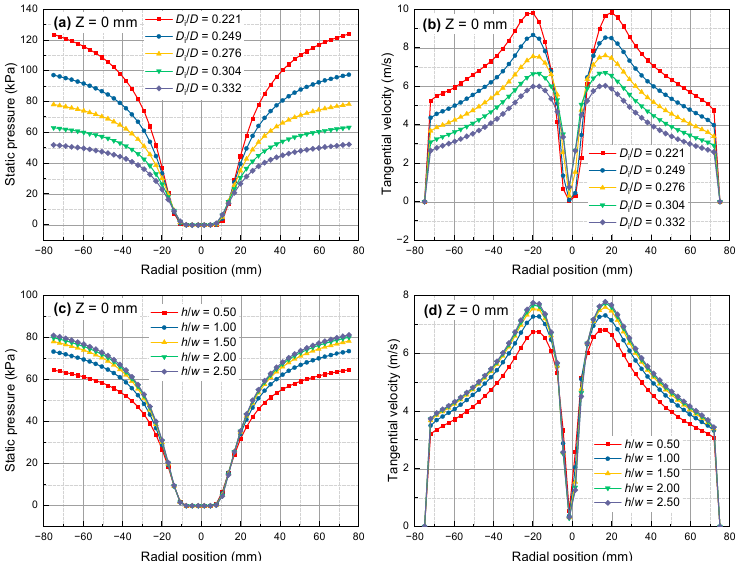
Figure 10. Effects of inlet structure on the distributions of pressure and tangential velocity ( a , b )—D i /D; ( c , d )—h/w.